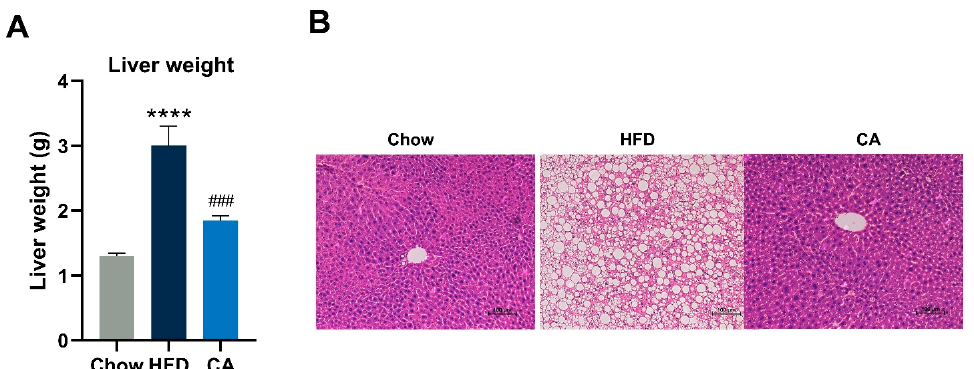
Figure 5. CA alleviates HFD-induced hepatic lipid accumulation. ( A ) Liver weight. ( B ) H&E-stained sections of liver. Bar = 100 μ m. Data are expressed as means ± SEM ( n = 8). **** p < 0.0001 vs. Chow group, ### p < 0.001 vs. HFD group.